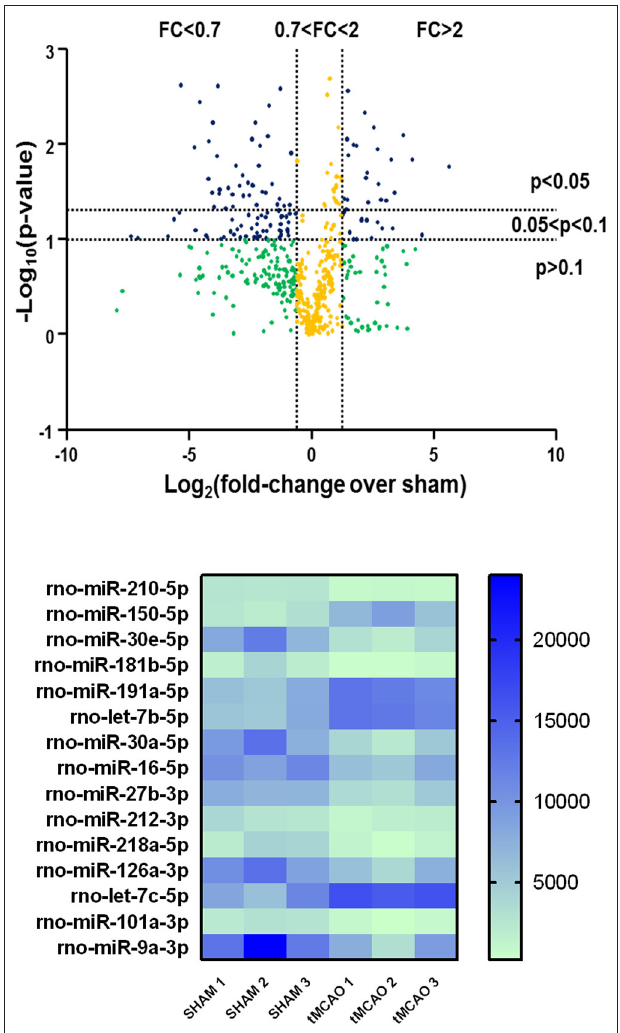
FIGURE 1 | Volcano plot analysis of microRNA expression profiles in the whole ischemic area from sham and transient middle cerebral artery occlusion (tMCAO) animals. Volcano plot analysis in the higher side of the panel shows the miRNA expression changes after tMCAO induction according to a microarray analysis. The y-axis corresponds to the negative log 10 ( p -value), and the x-axis displays the log 2 (fold change) value. The blue dots represent the miRNAs of the tMCAO group with variations of fold change more than 2 or < 0.7 compared to the sham group, with a p < 0.1. The yellow dots belong to miRNAs whose expression changes were less relevant, with fold change values between 0.7 and 2. The green dots comprise miRNAs with high fold change values but statistically not significant ( p > 0.1). A heat map of the 15 microRNAs selected from a microarray analysis is shown in the lower side of the panel. The signal intensity values for each significantly expressed miRNA of each sample are reported ( p < 0.05) in color-coded blocks, according to the colorimetric scale at the right side of the